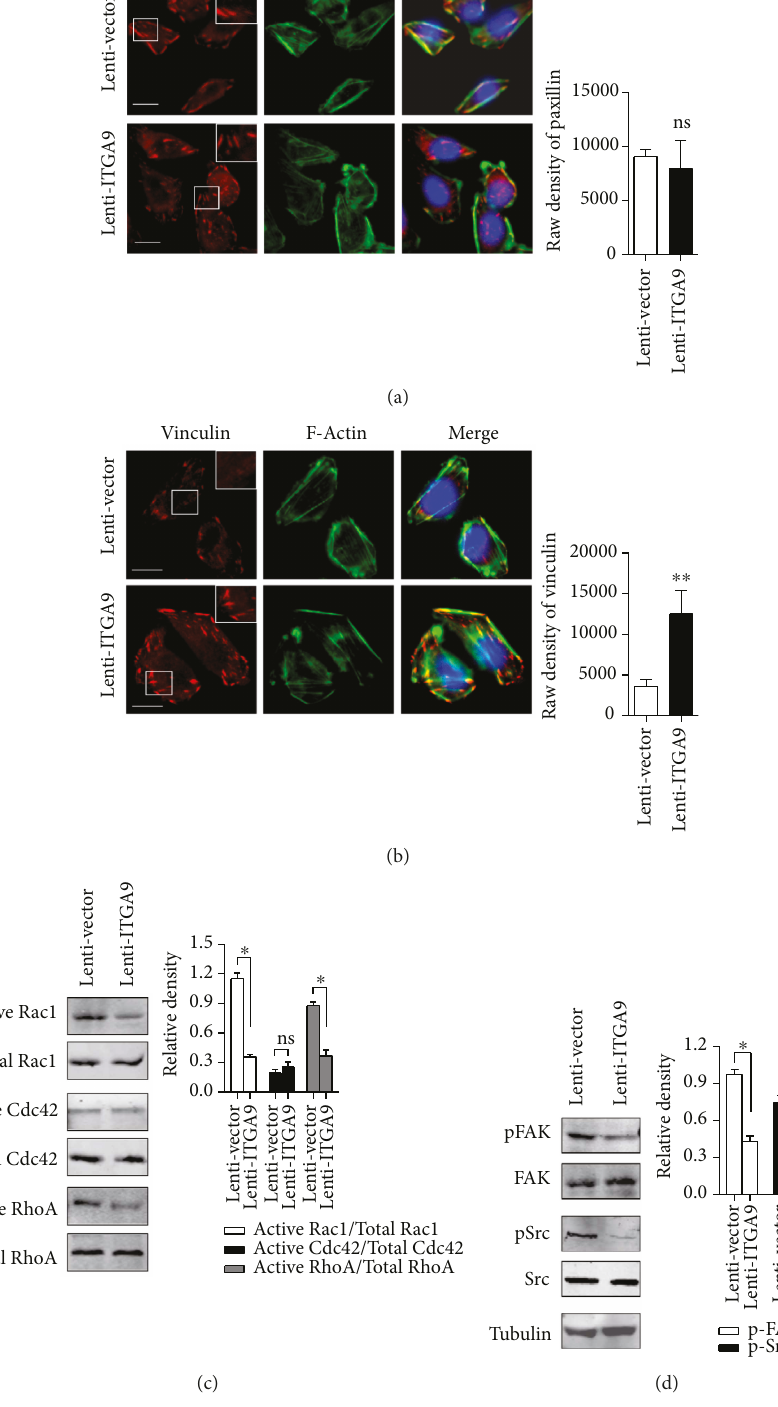
Figure 5: ITGA9 a ff ects focal adhesions and Rho GTPase activity. (a and b) Immuno fl uorescence staining of paxillin (red) and vinculin (red). F-Actin was stained by FITC phalloidin (green), and the cell nuclei were stained by DAPI (blue). Scale bars, 10 μ m. (c) Pull-down assays of the activities of RhoA, Cdc42, and Rac1 in ITGA9-overexpressed or control HCC cells. (d) FAK and Src phosphorylation of ITGA9-overexpressed versus control HCC cells. Tubulin was used as an internal control. Values are means ± SEM. ns: no signi fi cance. ∗ P < 0 05 and ∗∗ P < 0 01